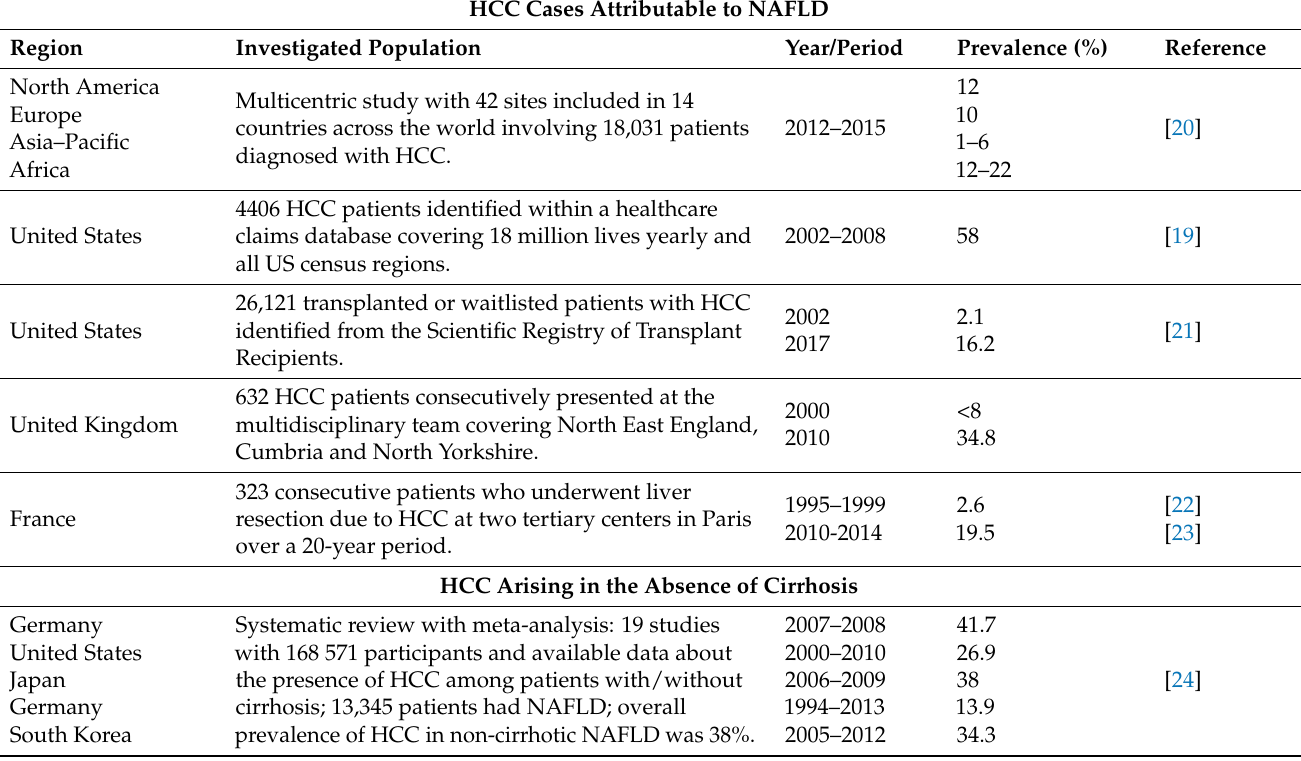
Table 1. Rates of hepatocellular carcinoma (HCC) attributable to non-alcoholic fatty liver disease (NAFLD) and those arising in non-cirrhotic liver, according to the geographic region and period. HCC Cases Attributable to